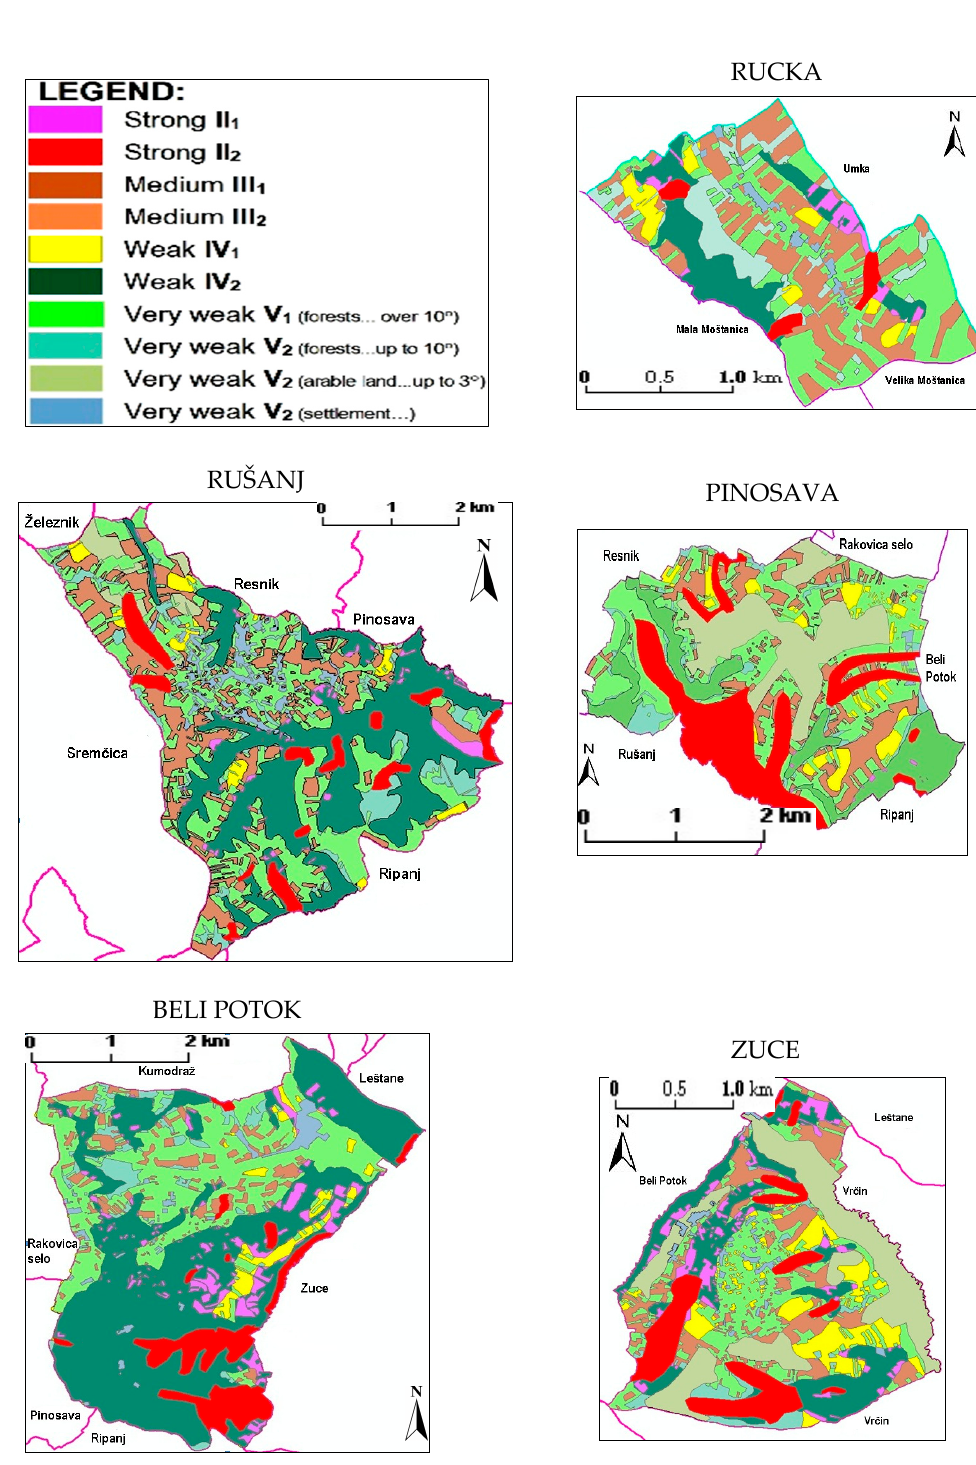
Figure 6. Erosion maps made after the corrections were entered from the field for 2018 for the settlements Rucka, Rušanj, Pinosava, Beli Potok, and Zuce. Erosion categories and coefficients are listed in Table S4.